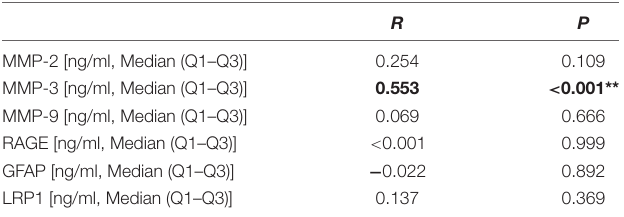
TABLE 7 | Correlations of PTA threshold with the levels of BBB factors in CSF from AD patients.